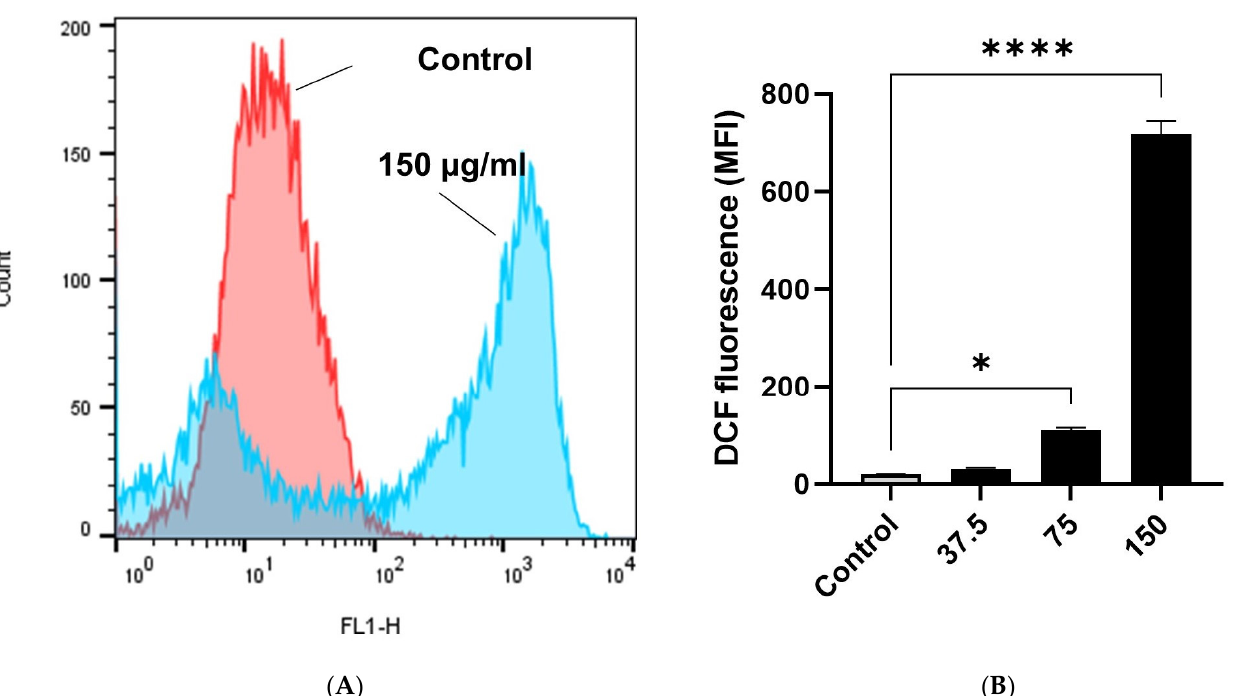
Figure 4. ( A ): Ethanol extract of C. calcitrapa (EECC) causes oxidative stress in MCF-7 cells. ( A ): His- togram represents relative DCF fluorescence intensity (FL1-H) vs. cell counts plot showing intra- cellular reactive oxygen species (ROS) generation in MCF-7 cells after 48 h exposure to EECC at the indicated concentration (150 µ g/mL), relative to the control. ( B ): Quantitation of mean DCF fluorescence (ROS) in MCF-7 cell lines exposed to different concentrations of EECC (37.5, 75 and 150 µ g/mL). * p < 0.05, **** = p < 0.0001 vs. control. Data represent mean ± SD of triplicates.